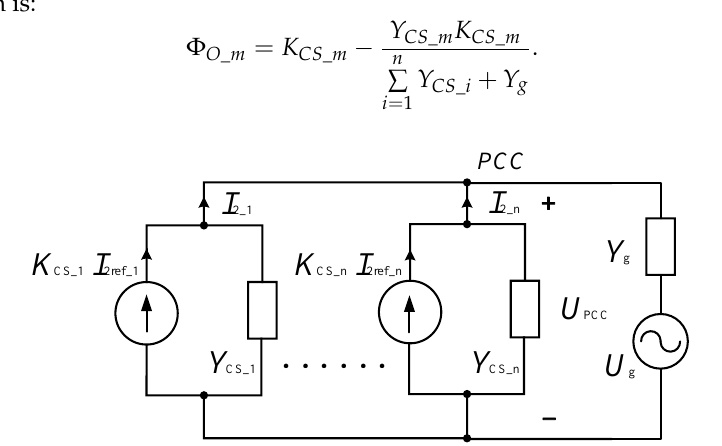
Figure 5. The Norton equivalent circuit of multi-parallel HCGIs system.